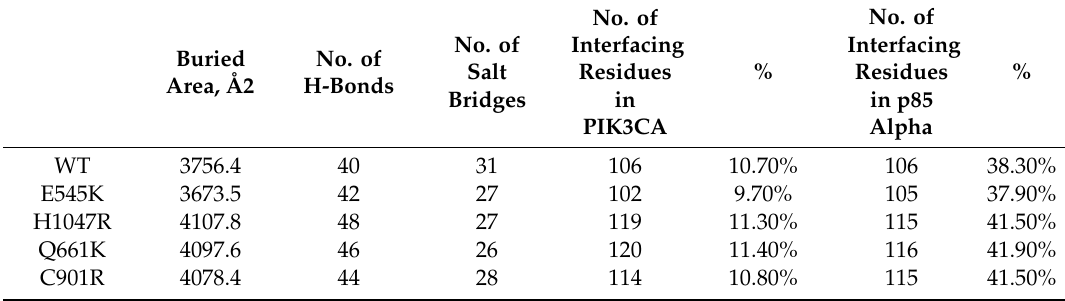
Table 3. Analysis of interactions between interface residues of the PIK3CA-niSH2 p85 alpha dimers as predicted by